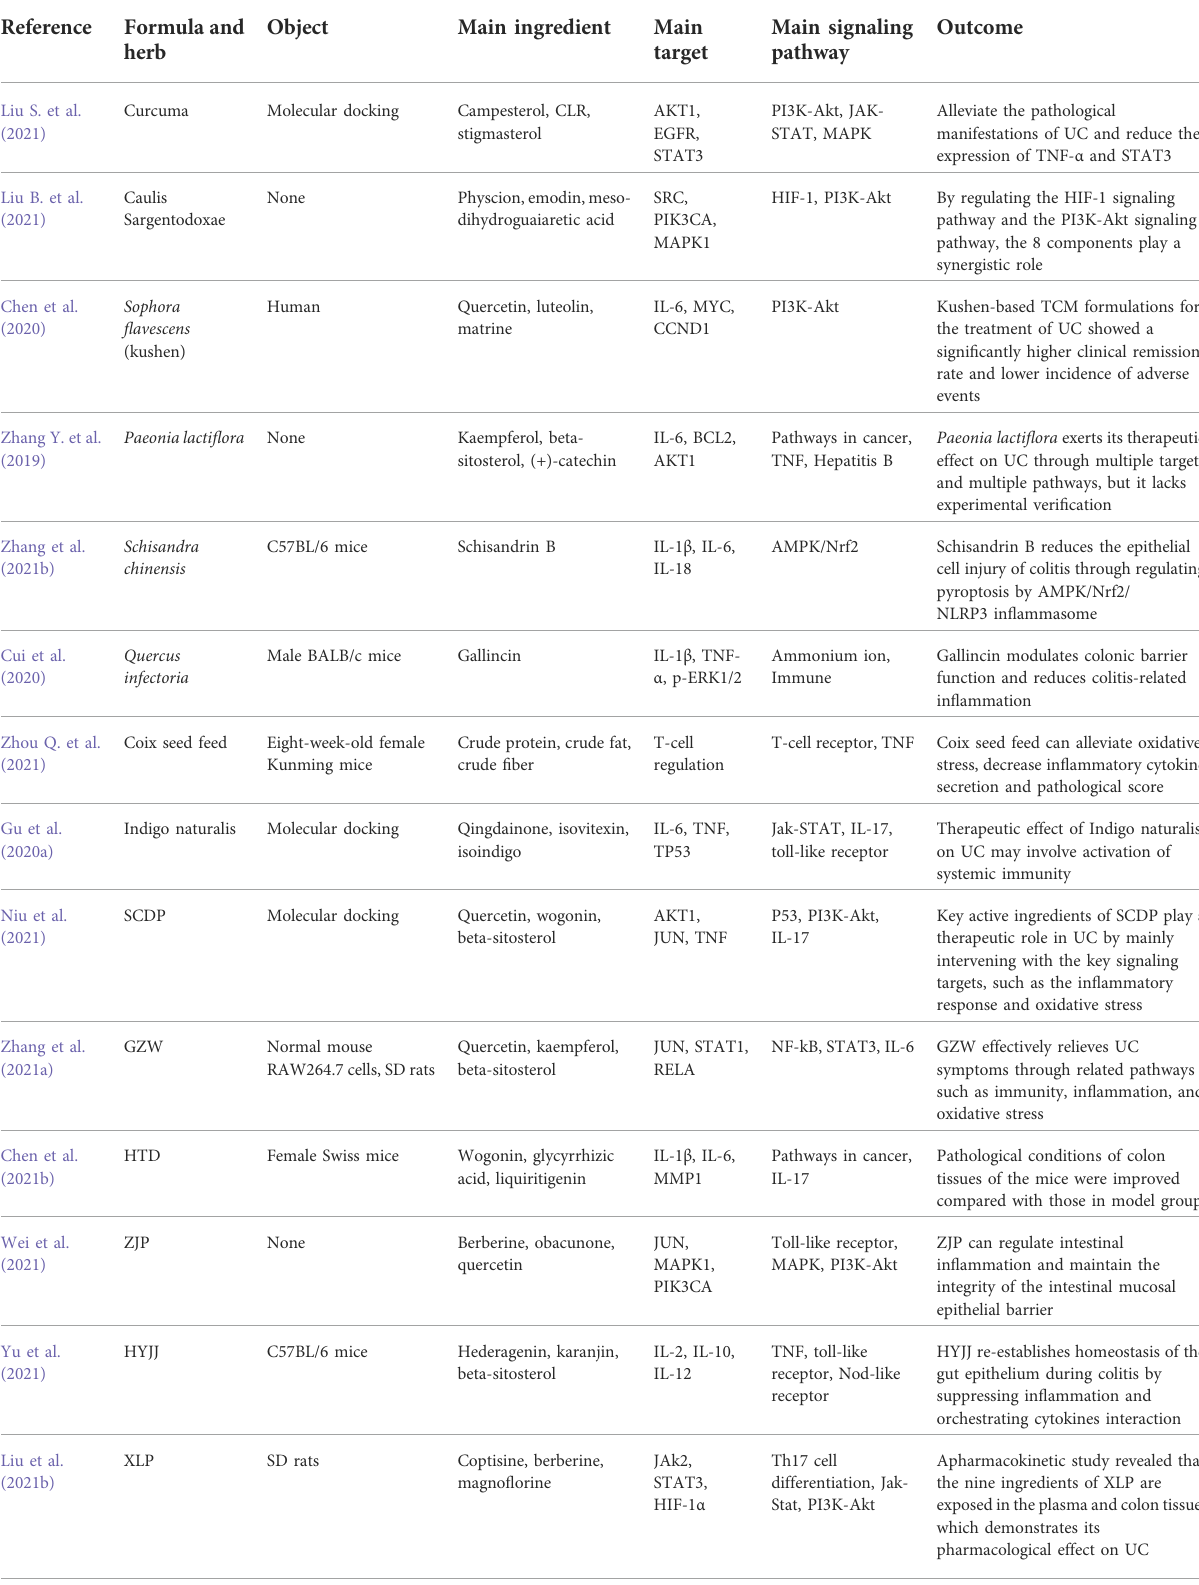
TABLE 2 Network pharmacology analysis of traditional Chinese medicine in the treatment of ulcerative